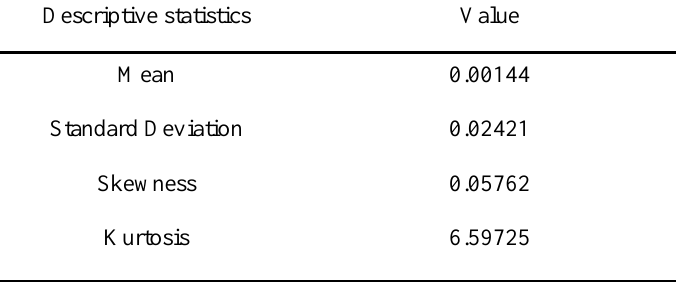
Table 1. Descriptive statistics of log-return WHGS3 sesame